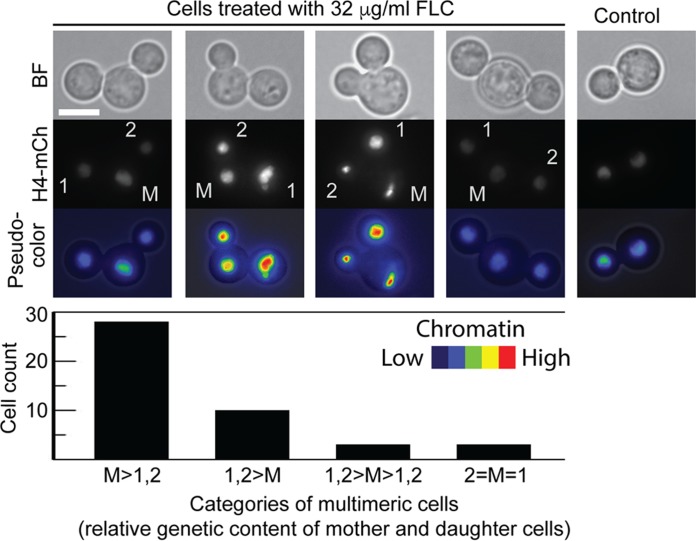
FLC treatment leads to unequal distributions of chromatin between the mother and the daughter cells. Cells expressing histone H4-mCherry (H4-mCh) from the endogenous promoter (CNV121) were treated with 32 μg/ml FLC for 12 h and imaged using Z-section fluorescence microscopy. A total of 44 multimeric cells were evaluated for the H4-mCherry signal in each of the cells constituting a trimera (M, mother; 1, first daughter; 2, second daughter). Cells were grouped depending on the relative amount of H4-mCherry fluorescence in each of the three cells as described in detail in Materials and Methods. The cells belonging to each category were counted as indicated. The meaning of each category is as follows: M>1,2, more signal in the mother than in either of the daughter cells; 1,2>M, more signal in either of the daughter cells than in the mother; 1,2>M>1,2, one daughter with more and one with less signal than the mother; 2=M=1, all three cells with equal levels of signal. Bar, 5 µm.